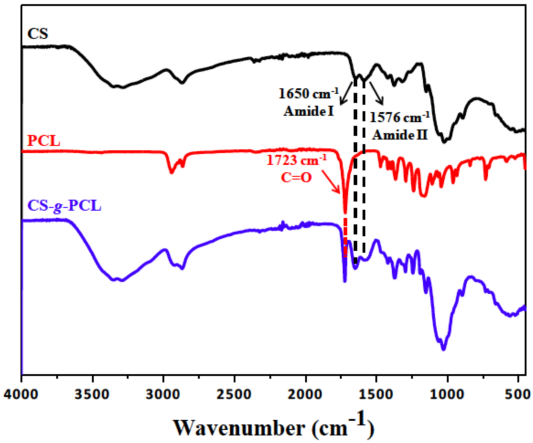
Figure 1. Attenuated Total Reflection-Fourier transform infrared (ATR-FTIR) spectrum of chitosan (CS), polycaprolactone (PCL) and the synthesized graft copolymer CS- g -PCL.